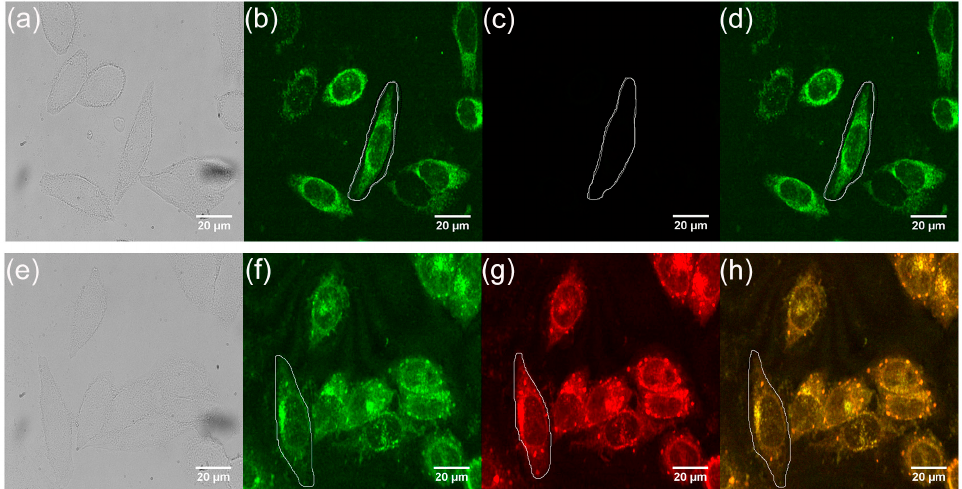
Figure 7. ( a – d ) The image of control group HepG2 cells without culturing with CdS QDs; ( a ) The bright field image; ( b ) The two-photon absorption fluorescence images with the green channel; ( c ) The red channel; ( d ) The combination image of green and red channels; ( e – h ) The images of HepG2 cells incubated with CdS QDs for 6 h; ( e ) The bright field image; ( f ) Two-photon absorption fluorescence images with the green channel; ( g ) The red channel; ( h ) Combination image of green and red channels. Table 3. The fluorescence brightness of the selected cell.